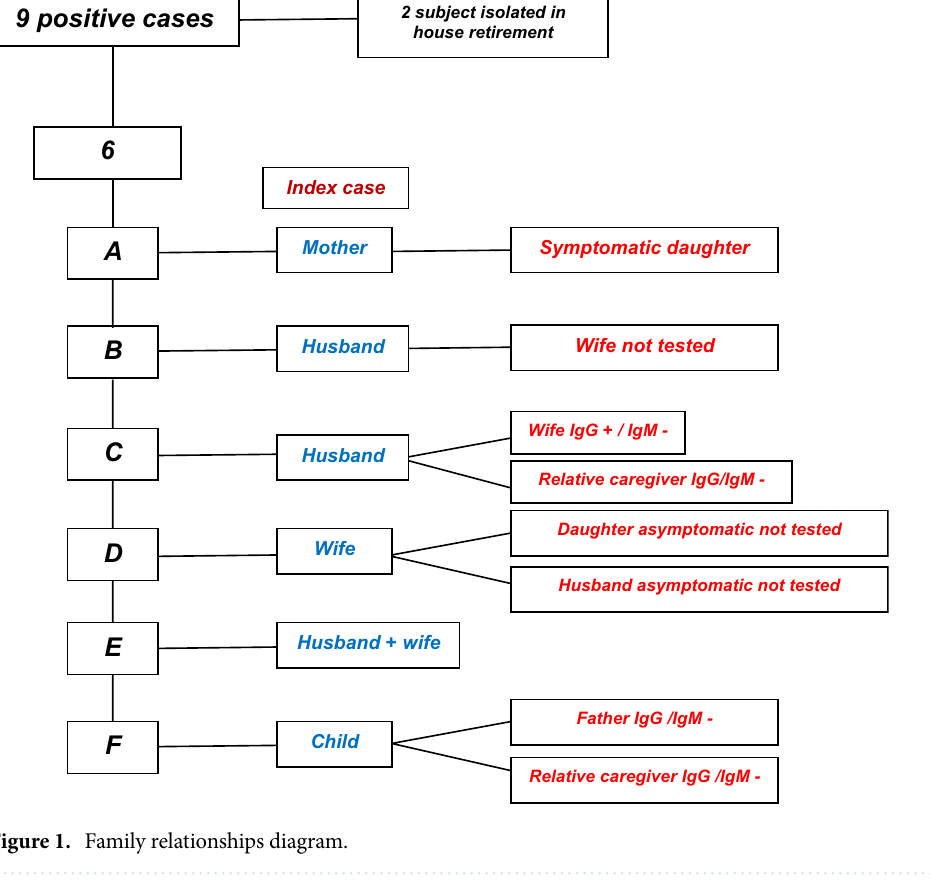
Figure 1. Family relationships